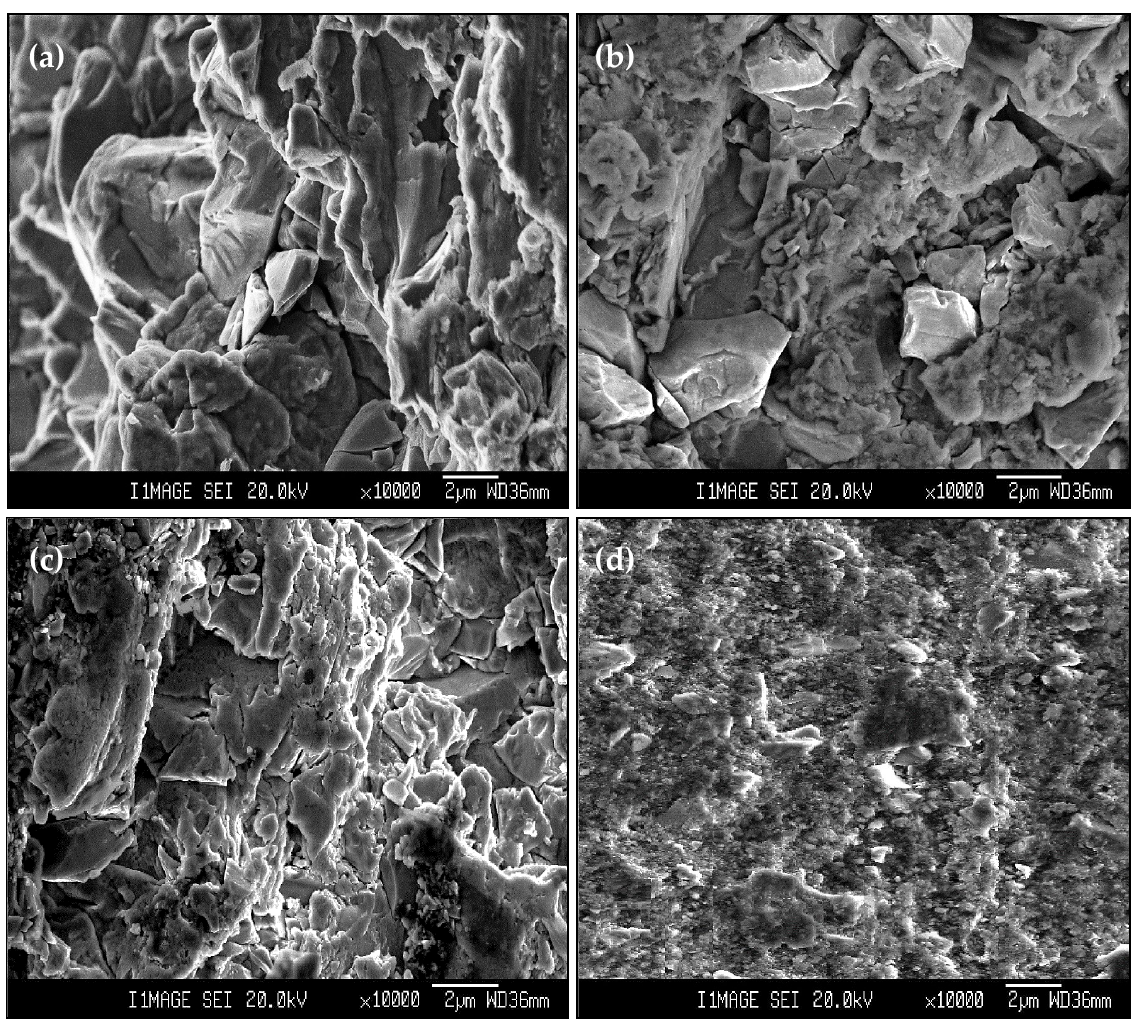
Figure 17. The wear debris of ( a ) PM Al-20% Al 2 O 3 , ( b ) PM Al-20% SiC, ( c ) HPT-processed Al-20% Al 2 O 3 , and ( d ) HPT-processed Al-20% SiC samples obtained under an applied load of 20 N and a sliding distance of 1260 m.